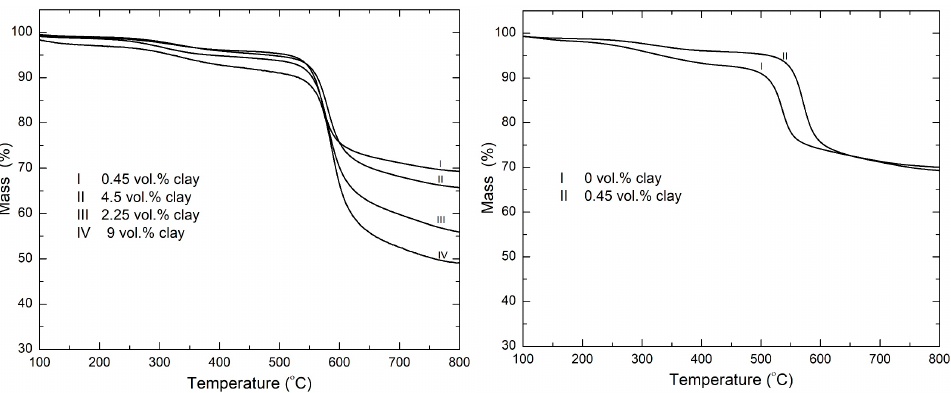
Figure 3. TGA mass loss profiles of PI-NGS-Clay nanocomposites in nitrogen atmosphere at a heating rate of 30 °C/min.